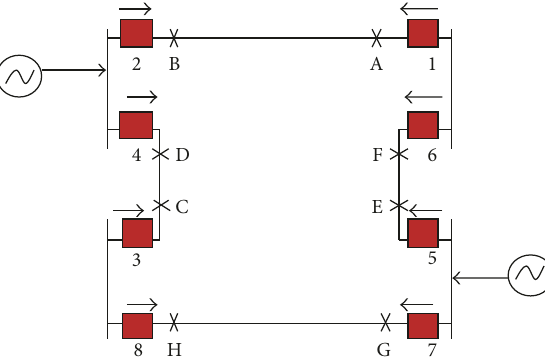
Figure 9: Model for the IEEE 4-bus system.